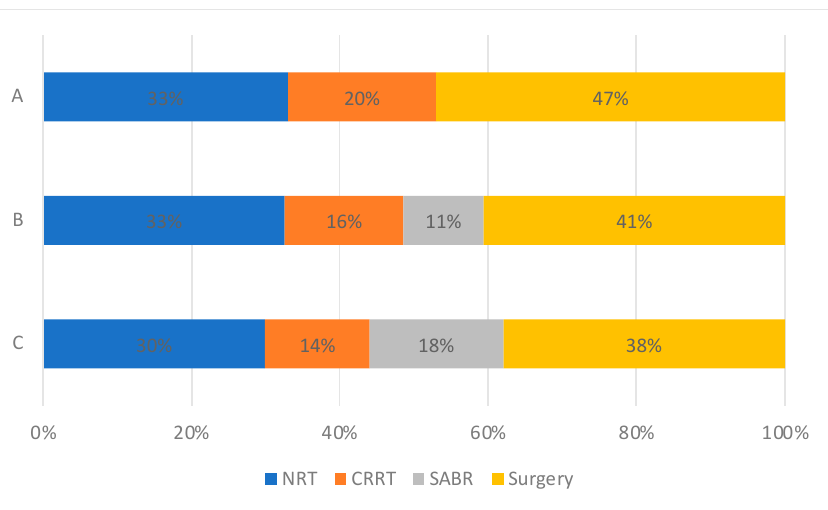
Figure 3. Treatment utilisation for all patients with stage I NSCLC by time period. (A: 2012-2103, Pre-SABR, B: 2104-2106, Introduction of SABR, C: 2017-2019, SABR Established).